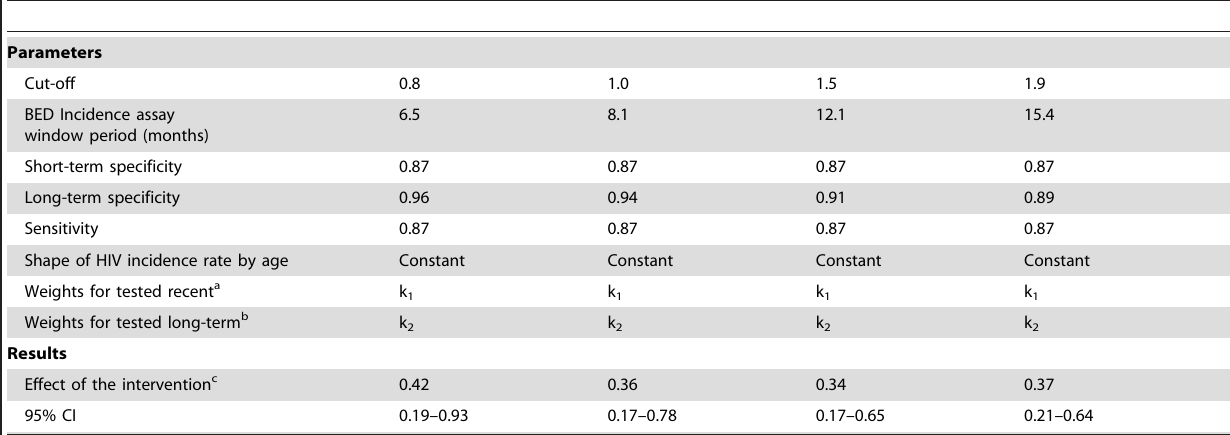
Table 3. Intention-to-treat effect of male circumcision estimated using BED incidence testing of blood samples obtained at the last follow-up visit of the Orange Farm male circumcision